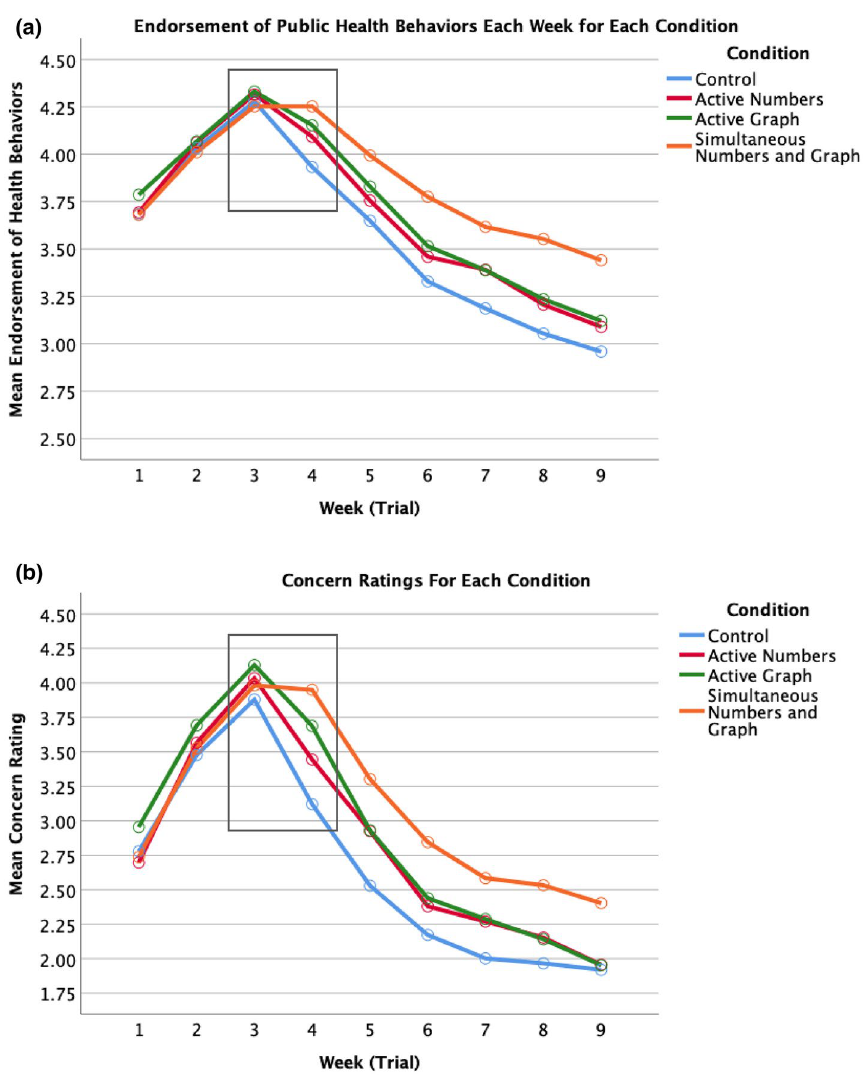
Figure 3. ( a ) Endorsement of public health behaviors each week by condition. ( b ) Concern ratings each week by